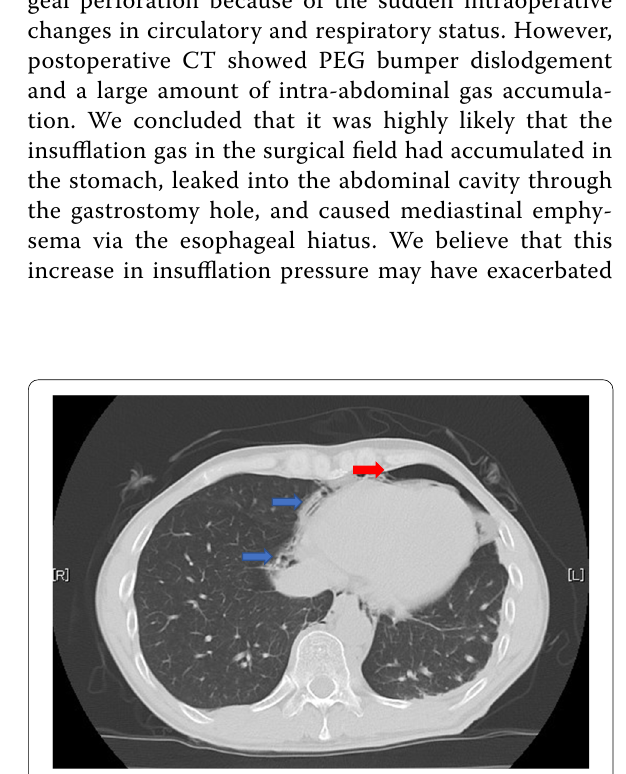
Fig. 3 Computed tomographic images. Thoracic computed tomography showing a left-sided pneumothorax (red arrow) and mediastinal emphysema (blue